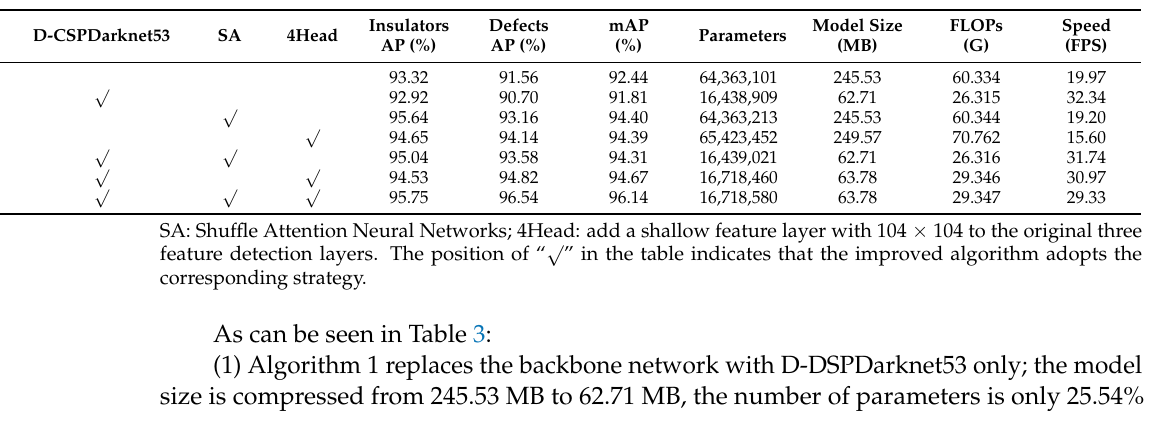
Table 3. Comparison of evaluation indicators of various improved